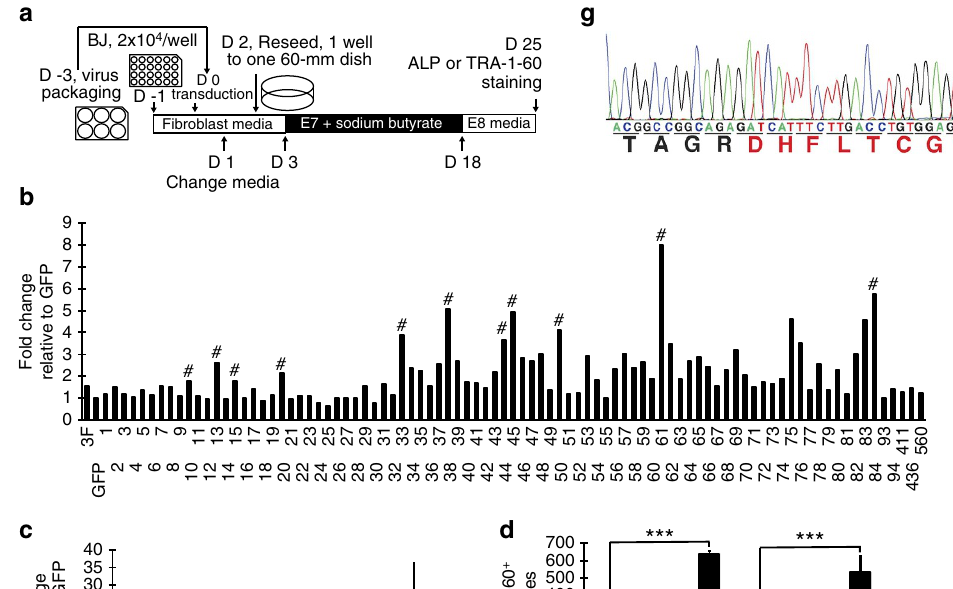
The iPSCs generated using BRD3R (3RiPSC) are pluripotent as demonstrated by several criteria. They expressed the established pluripotent markers (OCT4, SOX2, NANOG, LIN28, TRA-1-60, TRA-1-81, SSEA3 and SSEA4; Supplementary Fig. 2a), produced well-differentiated teratomas (Supplementary Fig. 2b), silenced transgenes (Supplementary Fig. 2c), generated embryoid bodies (Supplementary Fig. 2d), differentiated into multiple lineages in vitro (Supplementary Fig. 2e), acquired a pluripotent transcriptome (Supplementary Fig. 2f), and acquired a typical pluripotent cell cycle structure (Supplementary Fig. 2g). These